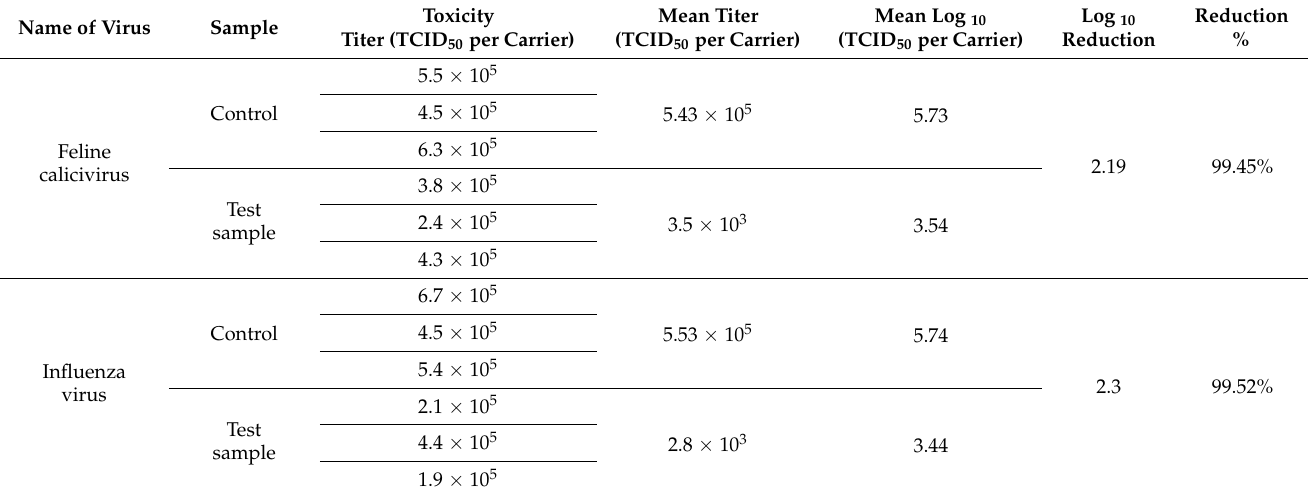
Figure 8. The reduction in virus infectivity in percentage against untreated sample and silver treated samples. Table 6. Measurement of virus infectivity in reduction